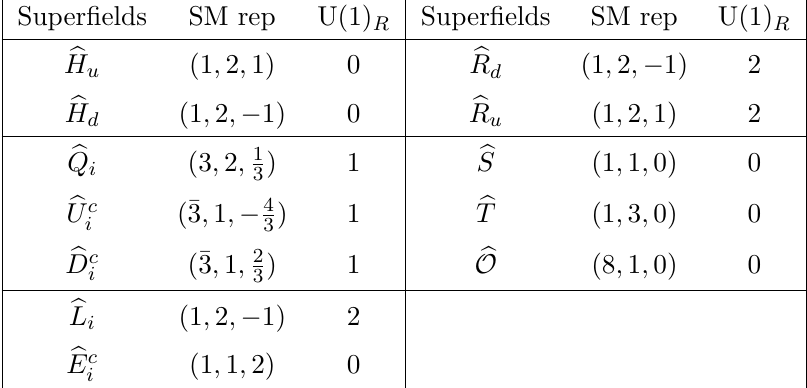
Table 1 . The gauge quantum numbers under the SM gauge group SU(3) well as the U(1) R charge assignments of the chiral super(cid:12)elds residing in the model. trilinear RPV terms will be present in the superpotential resulting in a mixing between light neutrinos and Dirac gauginos. Hence, one generates light neutrino masses at the tree-level. The RPV couplings will also allow the gravitino to decay to a neutrino and a photon. Such a gravitino is an excellent decaying dark matter candidate provided its lifetime is greater than the age of the universe and is consistent with di(cid:11)use gamma ray